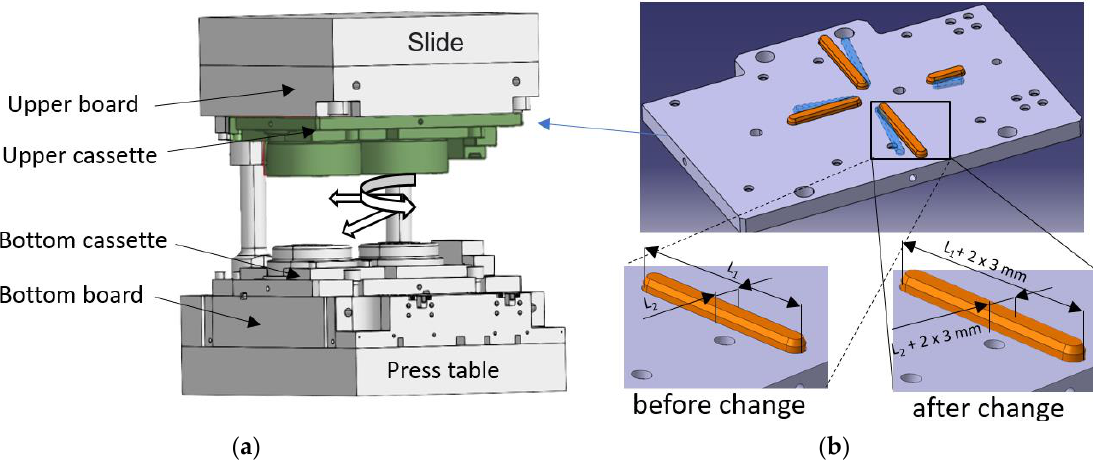
Figure 19. Concept of geometrical changes shown on a schematic diagram of the upper cassette SMED system: ( a ) the working space of the press, ( b ) introduced changes (the original arrangement/orientation of keyways are schematically marked in blue).